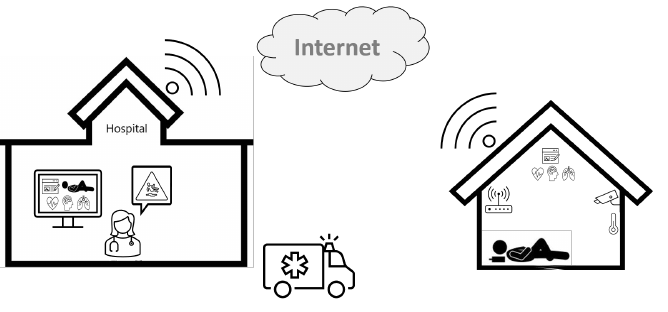
Figure 6. A Smart Space